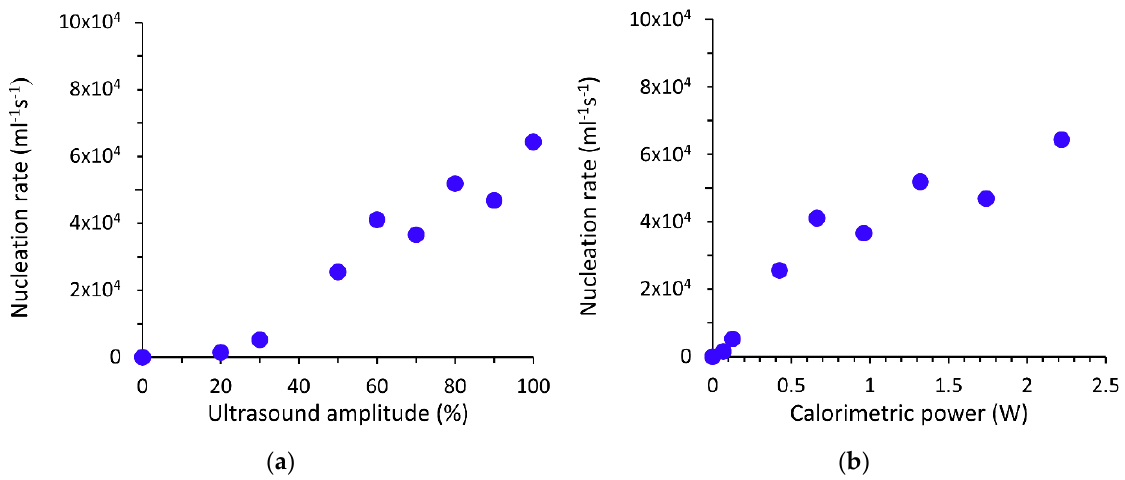
Figure 7. Nucleation rate in function of ( a ) the ultrasonic amplitude, and ( b ) the calorimetric ultrasonic power.